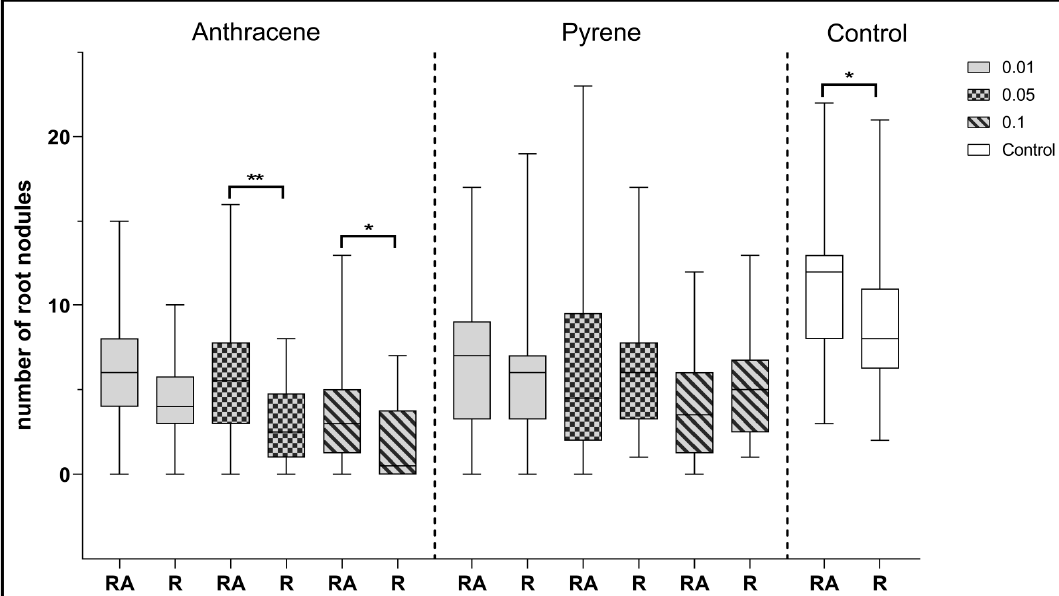
Figure 8. Comparison of the effect of inoculation of clover with only R. leguminosarum strains ( R) and with co-inoculation with A. brasilense (RA) on the average number of root nodules. Control samples were grown without PAH. The results are presented as a boxplot with median and 2.5–97.5 percentile. The symbols indicate significant results at: * p ≤ 0.05; ** p ≤ 0.01; *** p ≤ 0.001; α = 0.05 ( n = 24). No nodules were obtained from clover in combination with phenanthrene contamination. Table 5. Spearman’s correlation coefficients between observed parameters (average) of red clover and doses of PAHs: anthracene, phenanthrene, and pyrene for eight using strains of Rhizobium . Significant levels for the Spearman’s rank coefficients are indicated at the * p ≤ 0.05, *** p ≤ 0.001, and **** p ≤ 0.0001 levels.